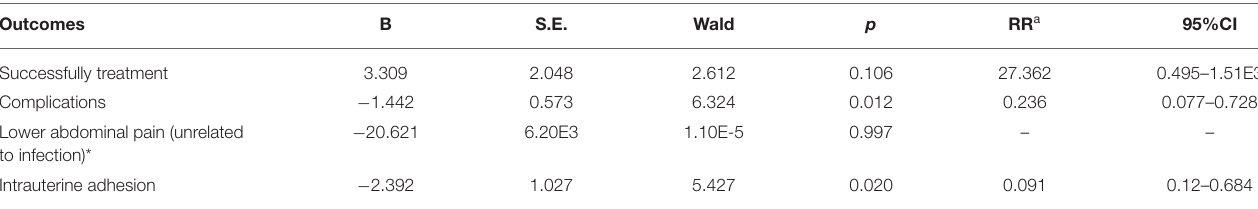
TABLE 4 | Multivariate logistic regression analysis of the effects of local methotrexate injection on cesarean scar pregnancy compared with uterine artery embolization. Outcomes